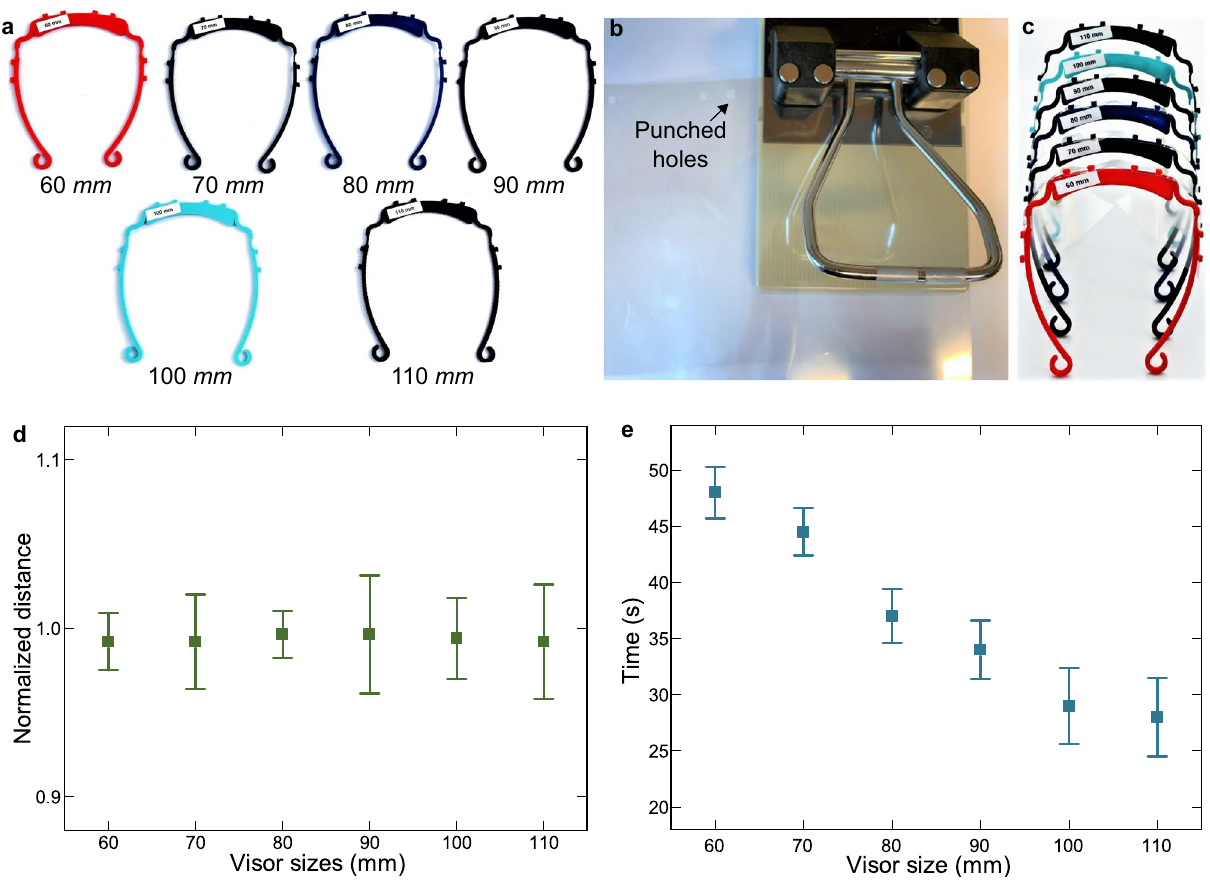
Figure 8. Fabricated visors. ( a ) Demonstration of visor frames with different sizes. The number below each visor frame is d which represents the distances between two feet of the visors. ( b ) Punch holes on the transparent films. ( c ) Assembled visors. Performance of the cascade PI controller in terms of ( d ) control accuracy and ( e ) time the visor as illustrated in Fig. 9b. The pressure values are considered as the contact pressure between the human head and the visor frame. For the FEM analysis, the material of the visor frame is set as PLA with the Tensile Modulus of 3.3 GPa and the Compression Modulus of 2.9 Gpa. The Poisson’s ratio is 0.35. Tetrahedral elements with sizes of 1 mm are used to mesh the visor frames. Figure 9c,d show the comparison of the stress distribution of the two visor frames with the same final foot distance of 100 mm. The original visor frame in Fig. 9c deforms from 45 mm and the customized visor frame in Fig. 9d is deformed from 60 mm. It can be observed that the shoulder and hinge of the original visor frame undertakes large stress up to 43.2 MPa while the narrowed part of the customized visor frame takes more deformation and has stresses up to 25.8 MPa, which is around 2/3 of the original visor frame. When the visor frames are worn, no matter what the initial sizes are, the visor frames will be bent to a larger size to match the head sizes of the users. The deformed visor size after the visor frames are worn is noted as wearing sizes. We assume six wearing cases where the wearing sizes vary from 80 to 130 mm with a step of 10 mm between different cases. The visor frame with the original design is firstly applied with different loads until the foot distances reach the wearing sizes. Fig. 9e shows the contact pressures in the six scenarios for the normal visor frame. The visor sizes remain at 45 mm while the wearing size increases gradually. Consequently, the contact pressures also increase from 4.9 kPa per side to 9.5 kPa, which makes the wearing experience quite different for different people. On the other hand, the CL4DP method fabricates visor frames with sizes 40 mm smaller than the wearing sizes as shown in Fig. 9f. For example, if the size of the visor after wearing 100 mm, then the fabricated visor using CL4DP is 60 mm. As a result, the visor size changes for different scenarios are all around 40 mm. Thus the contact pressures are also similar in different cases as indicated by the FEM results in Fig. 9f. The contact pressures are around 1.3 kPa and a very small contact pressure drop can be noticed for larger wearing sizes. The difference of contact pressures are less than 3% , which exhibits excellent consistences in wearing experiences with a large variation in wearing sizes.